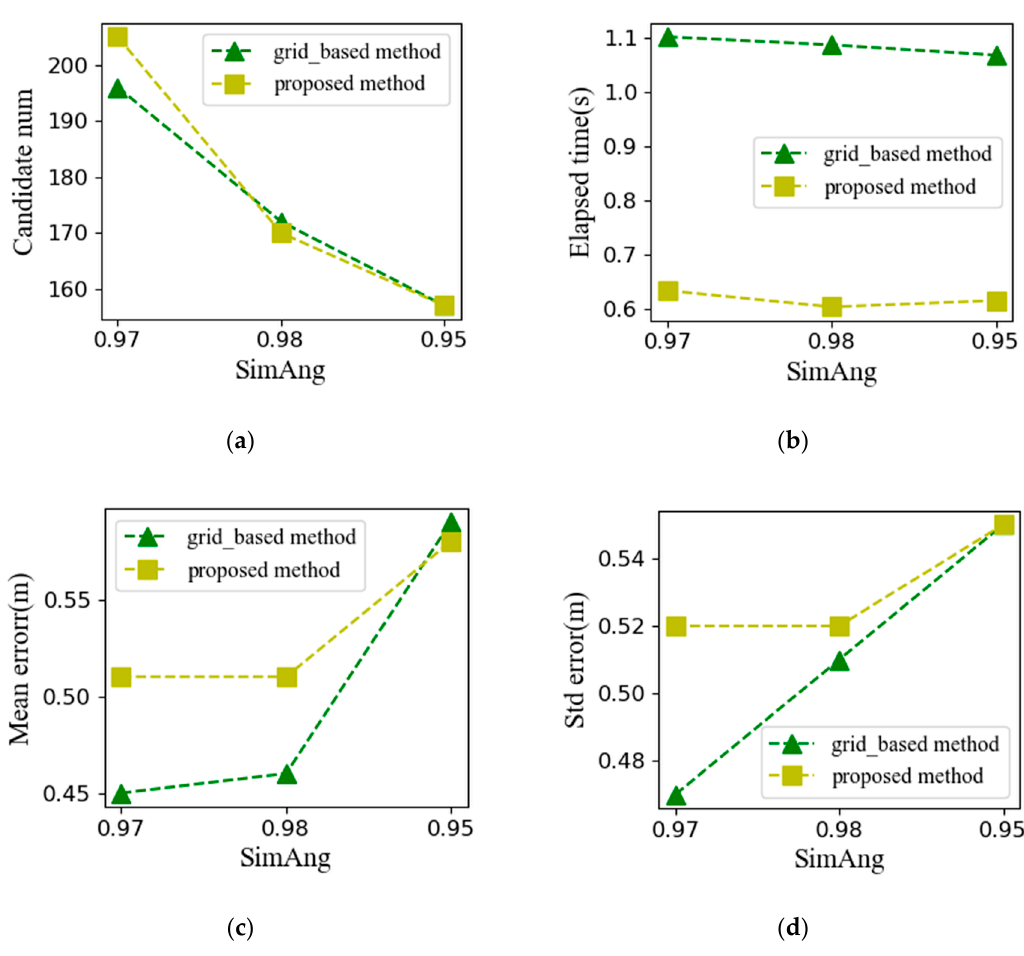
Figure 13. Similarity of angle (SimAng) effect results: ( a ) Candidate set size; ( b ) elapsed time; and ( c , d ) accuracy of the grid-based algorithm and the proposed algorithm with different SimAng values.